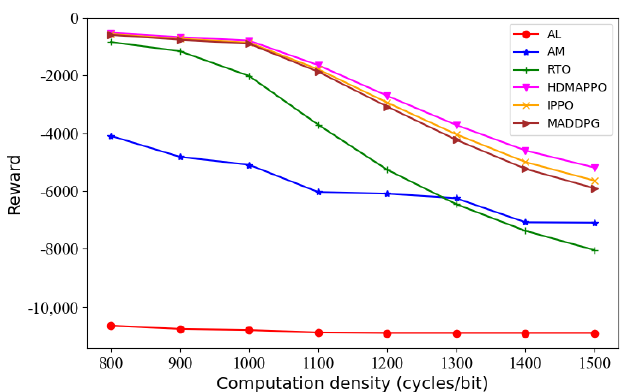
Figure 6. Impact of the calculation density of the task on the system’s